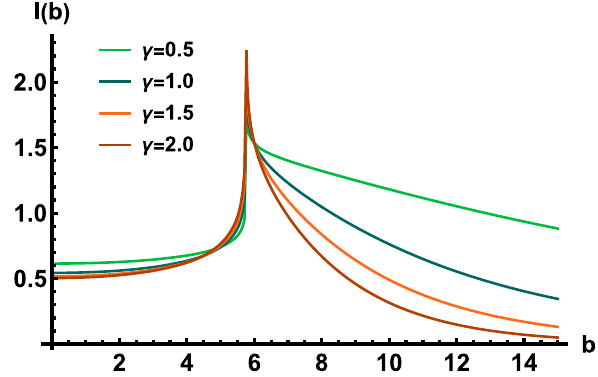
Fig. 5 The specific intensity with different γ in static spherical accre- tion with fixed β = 0 . 1 , P = 0 . 6, and M = 1